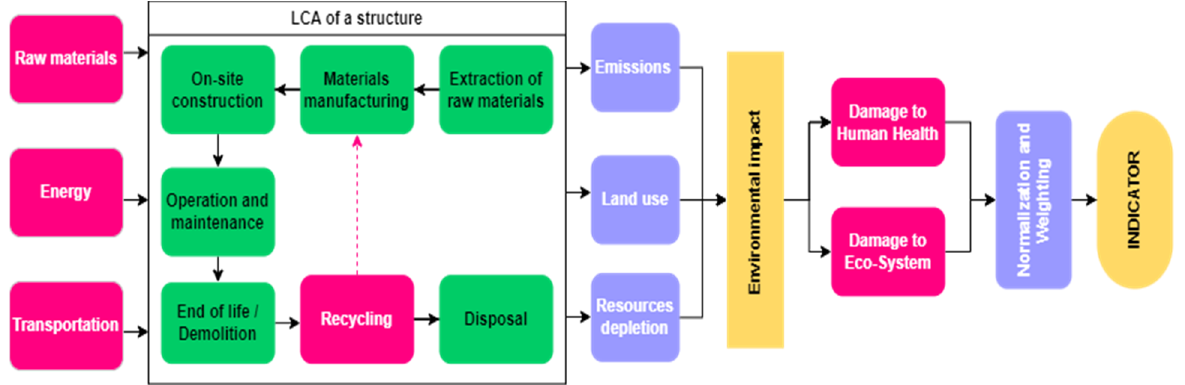
Figure 1. Flow chart of the LCA, including input and output flows of materials, energy and pollutants from a life cycle perspective.